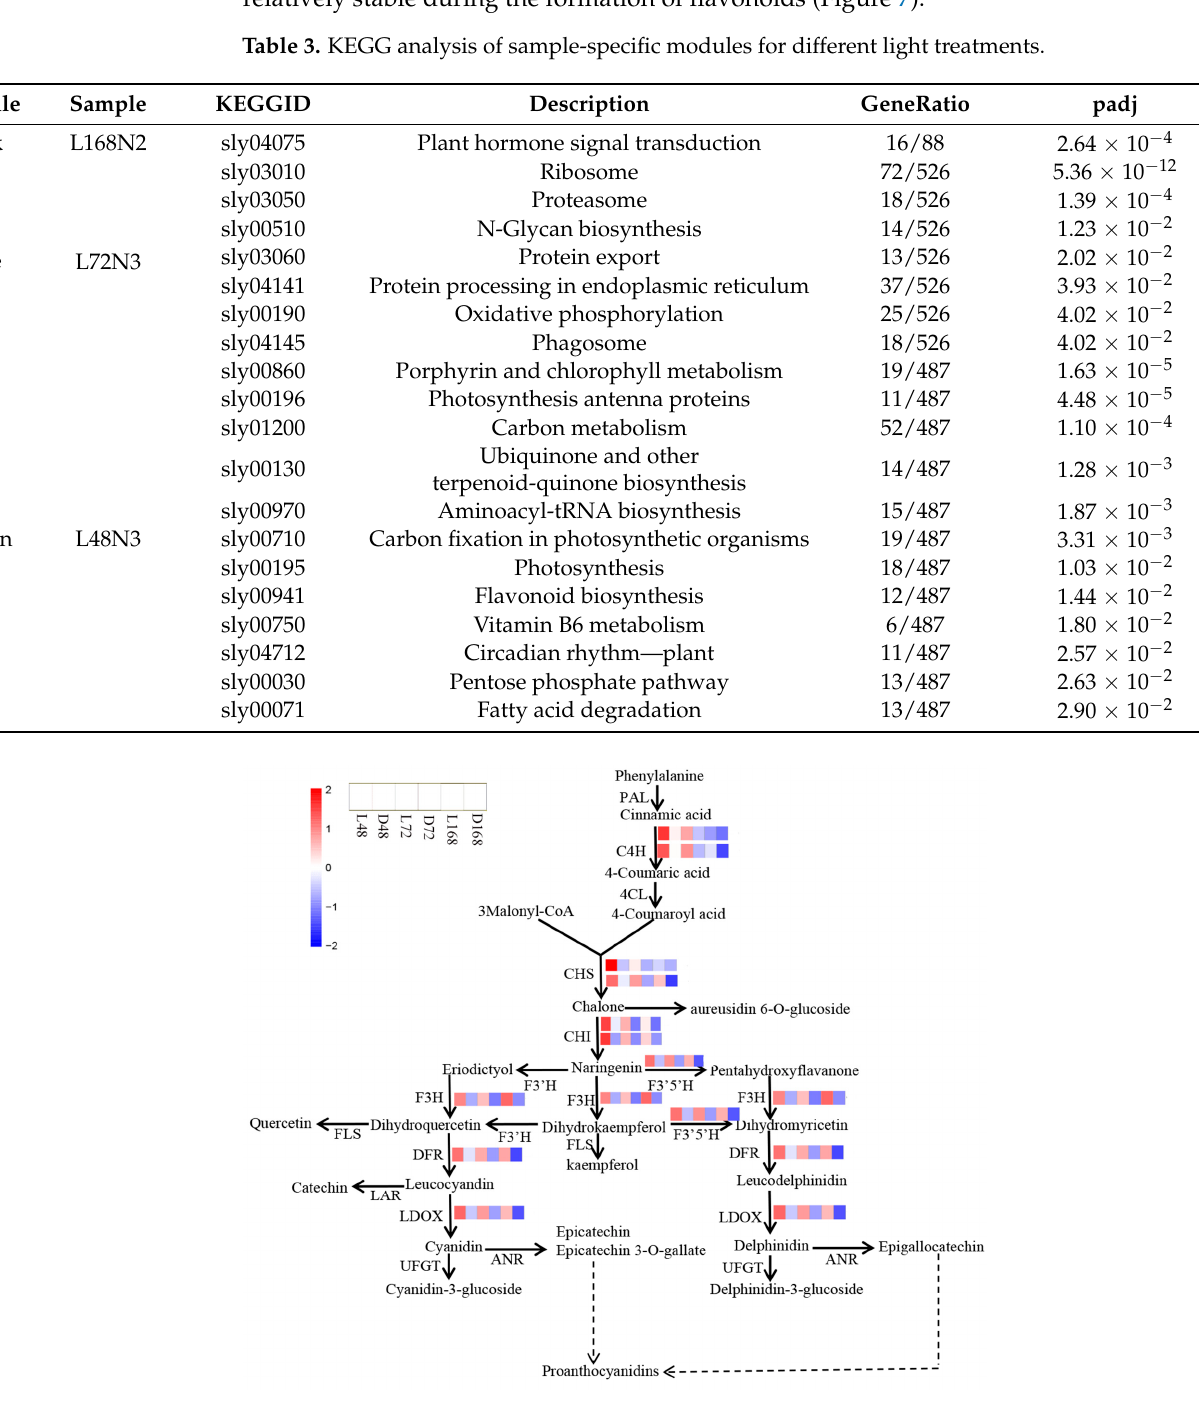
Figure 7. Expression patterns of DEGs in flavonoid synthesis pathways of different light treatment samples. The heatmap shows the expression patterns of differentially expressed structural genes related to the flavonoid pathway in pepper peels at different stages (upper left). Each row represents a unigene, and the expression change in the unigenes is based on the FPKM (the number of kilobase fragments of exon per million reads). The closer to blue, the lower the expression, and the closer to red, the higher the expression.